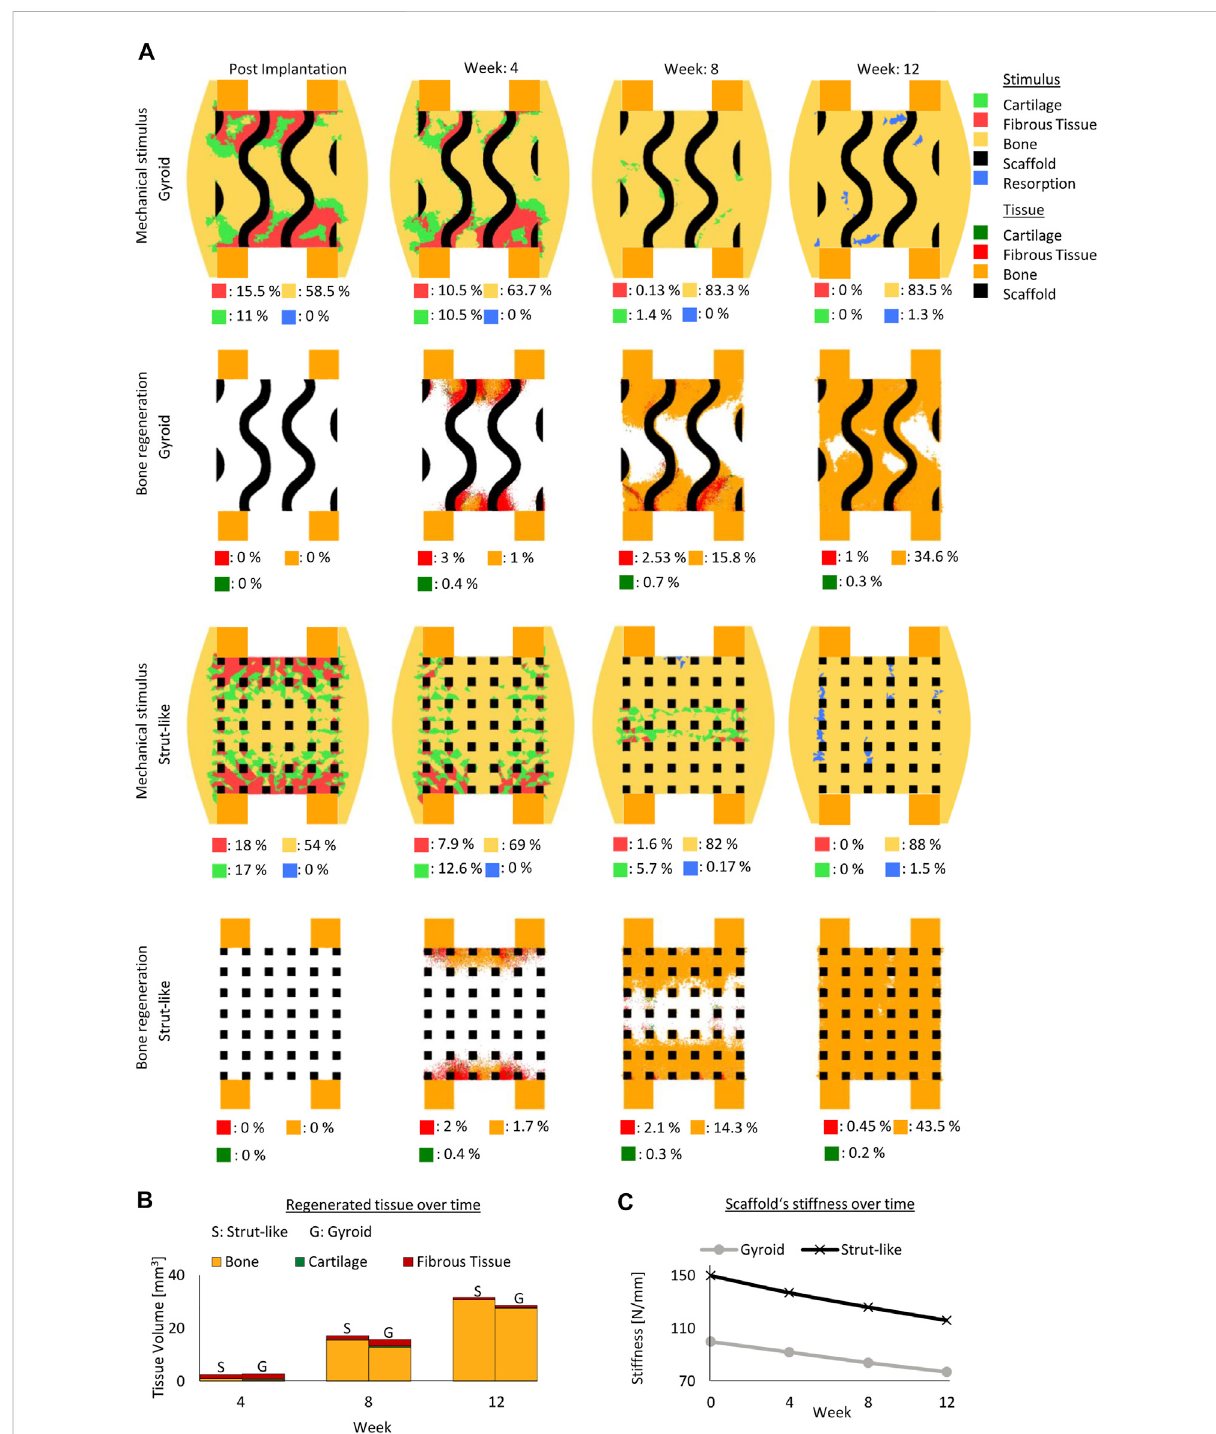
FIGURE 4 Predicted bone, cartilage and fi brous tissue within the scaffold pores at 4, 8 and 12 weeks of healing for scaffolds with strut-like and gyroid architecture with 69% porosity. (A) : Longitudinal cross sections of the callus from Figure 1A with quanti fi ed tissue regeneration in the 2D section, mechanical stimulus distribution over time using a strut-like scaffold, predicted tissue distribution over time using a strut-like scaffold, mechanical stimulus distribution over time using gyroid scaffold and predicted tissue distribution over time using a gyroid scaffold. (B) : Total tissue volume predicted within thescaffold pores atdifferentstages ofhealing. (C) :Mechanicalstiffness ofscaffoldscomputed fromcompression tests atdifferent stages of